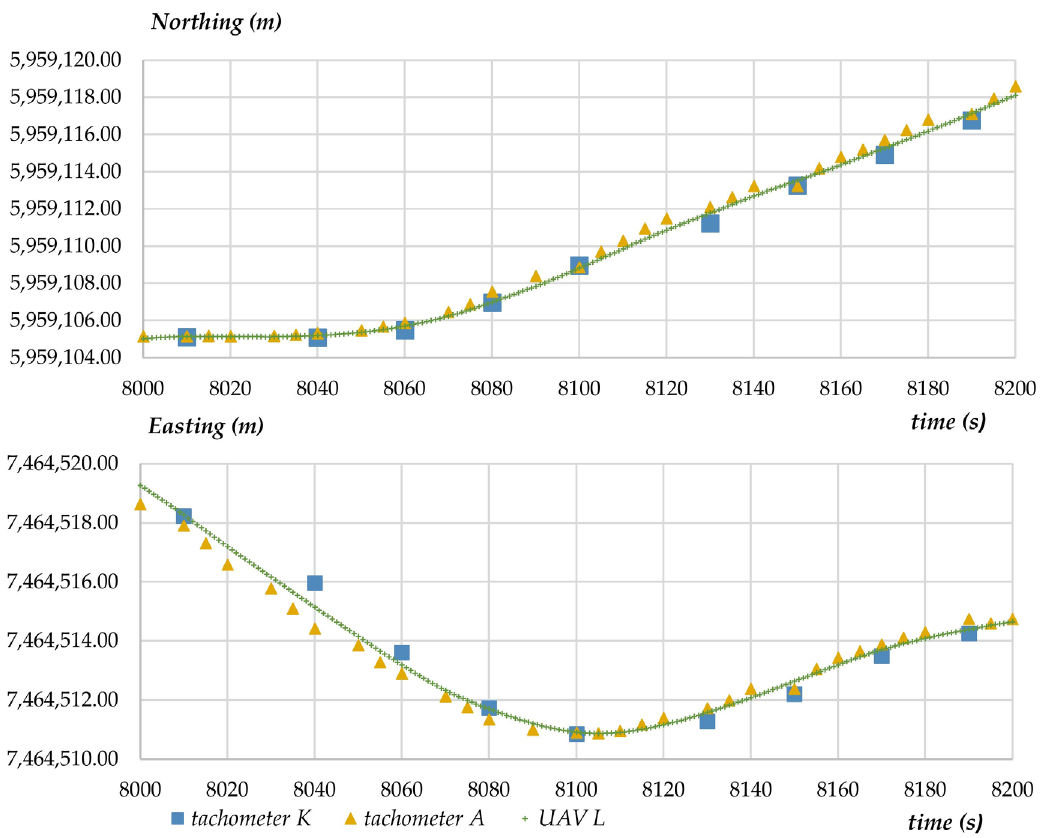
F igure 12. Variability in X- and Y-coordinates determined with the analyzed measuring techniques.